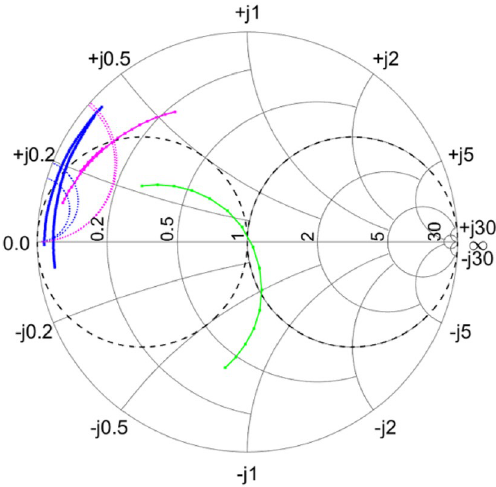
Figure 6. Smith chart showing impedance trajectories for ECD reflectometry measurements using two similar calibrations for MN composed of L = 240 nH inductor and C IN 0 (blue dots), 15 pF (magenta dots), 30 pF = (greeen dots). Imperfections in calibration results in uncertain definition of C IN needed to achieve good match for C IN 0. A ”half-capacitance” guess (magenta dots) results in a much more accurate determination of C IN =